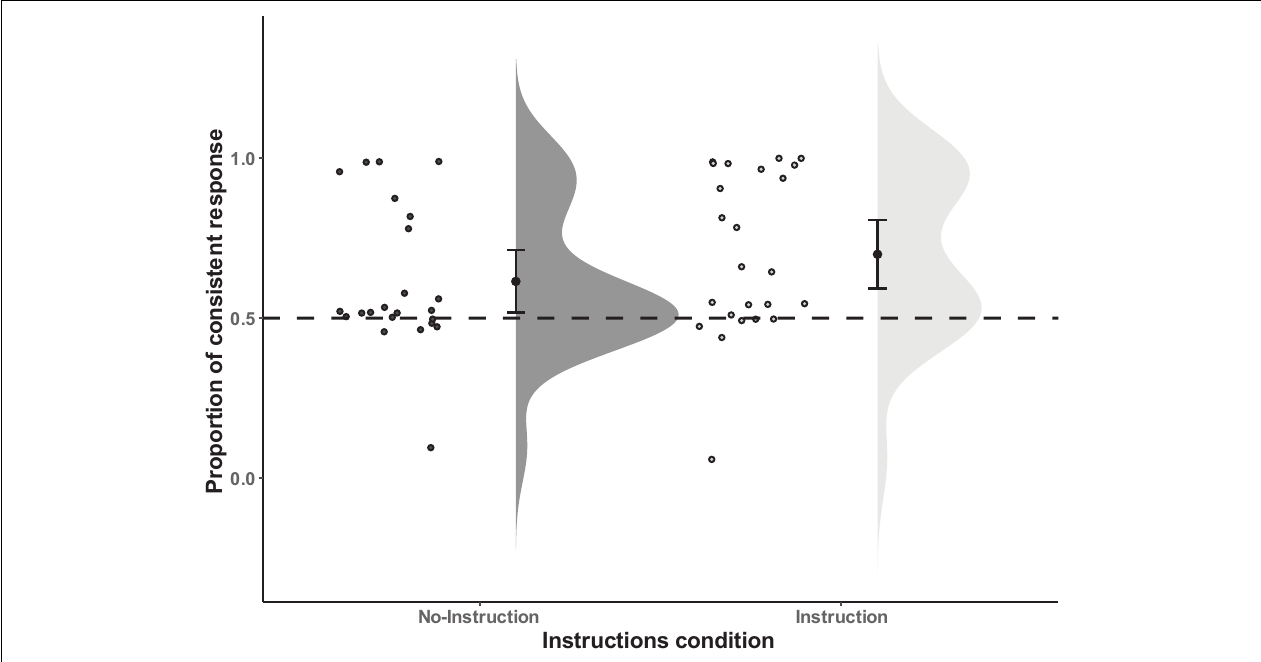
FIGURE 2 | Distribution of the proportion of consistent responses of all the individual data points in Experiment 1. Error bars represent the 95% confidence intervals.